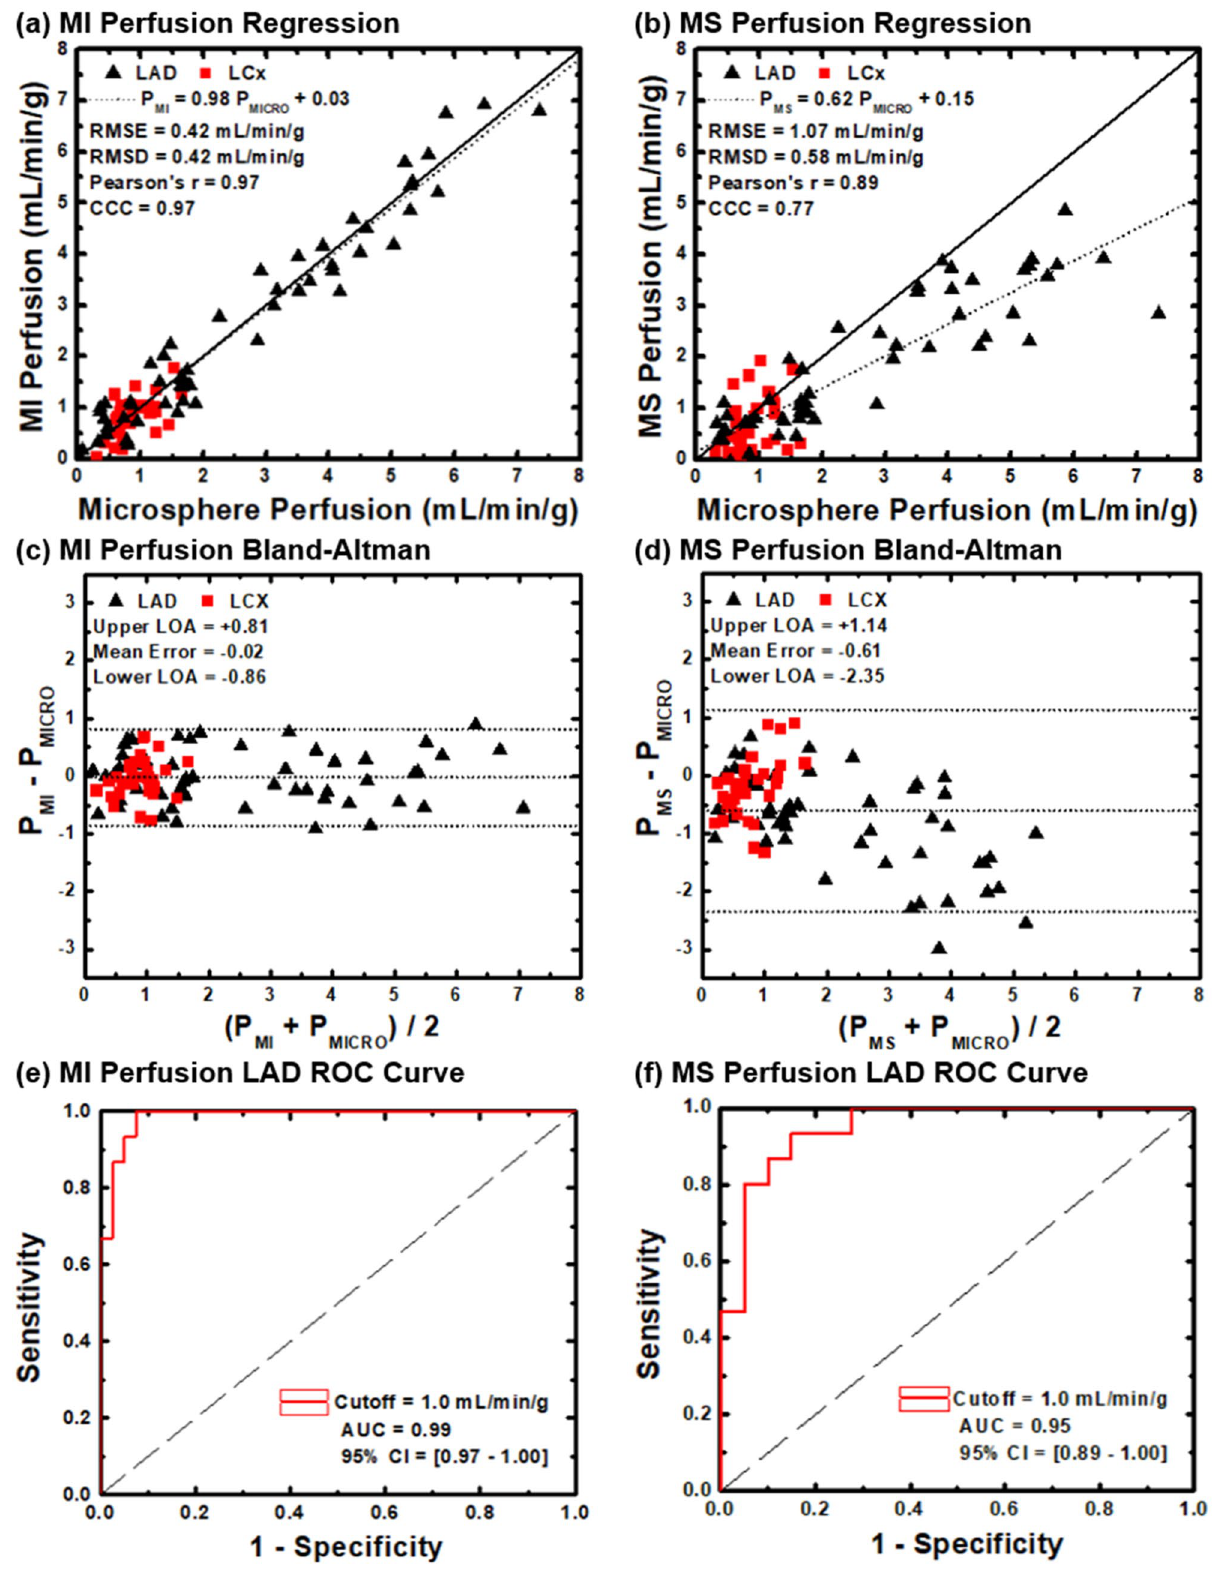
Figure 2. Accuracy and diagnostic performance. Regression analysis comparing ( a ) MI and ( b ) MS perfusion measurement to reference standard microsphere perfusion measurement. Bland–Altman analysis comparing ( c ) MI and ( d ) MS to reference standard microsphere perfusion measurement. AUC of the ROC for the ( e ) MI and ( f ) MS techniques in detection of functionally significant LAD stenosis, defined as stress perfusion less than 1.0